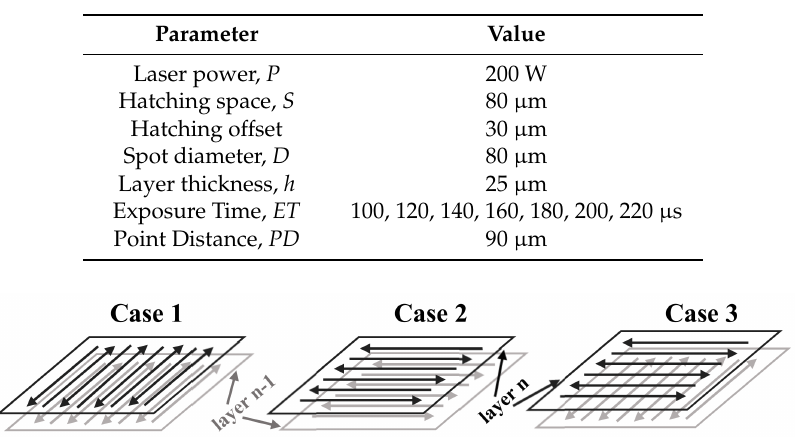
Figure 1. Overview of the meander scan mode. In the three cases, the rotation start angle and rotation increment angle are 0 ◦ , 90 ◦ , 0 ◦ and 0 ◦ , 0 ◦ , 90 ◦ , respectively.